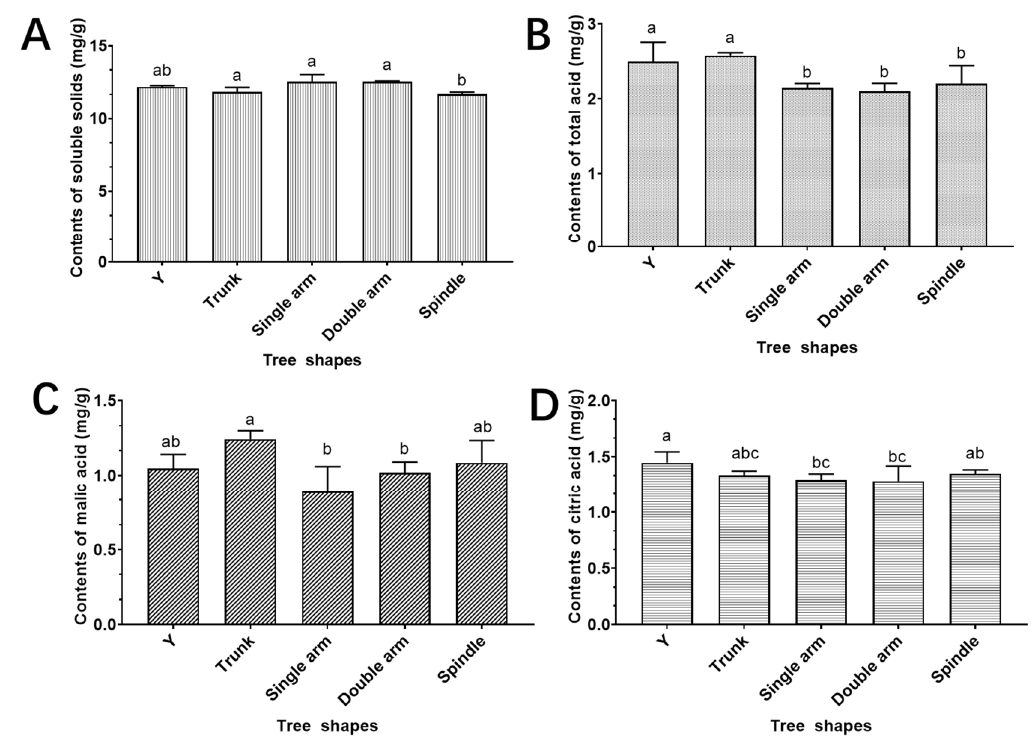
Figure 6. The effects of different tree shapes on the content of soluble solids ( A ), total acid ( B ), malic acid ( C ), and citric acid ( D ). The error bars represent the standard deviation (SD), and the lowercase letters indicate statistically significant ( p < 0.05) differences between each tree shape.